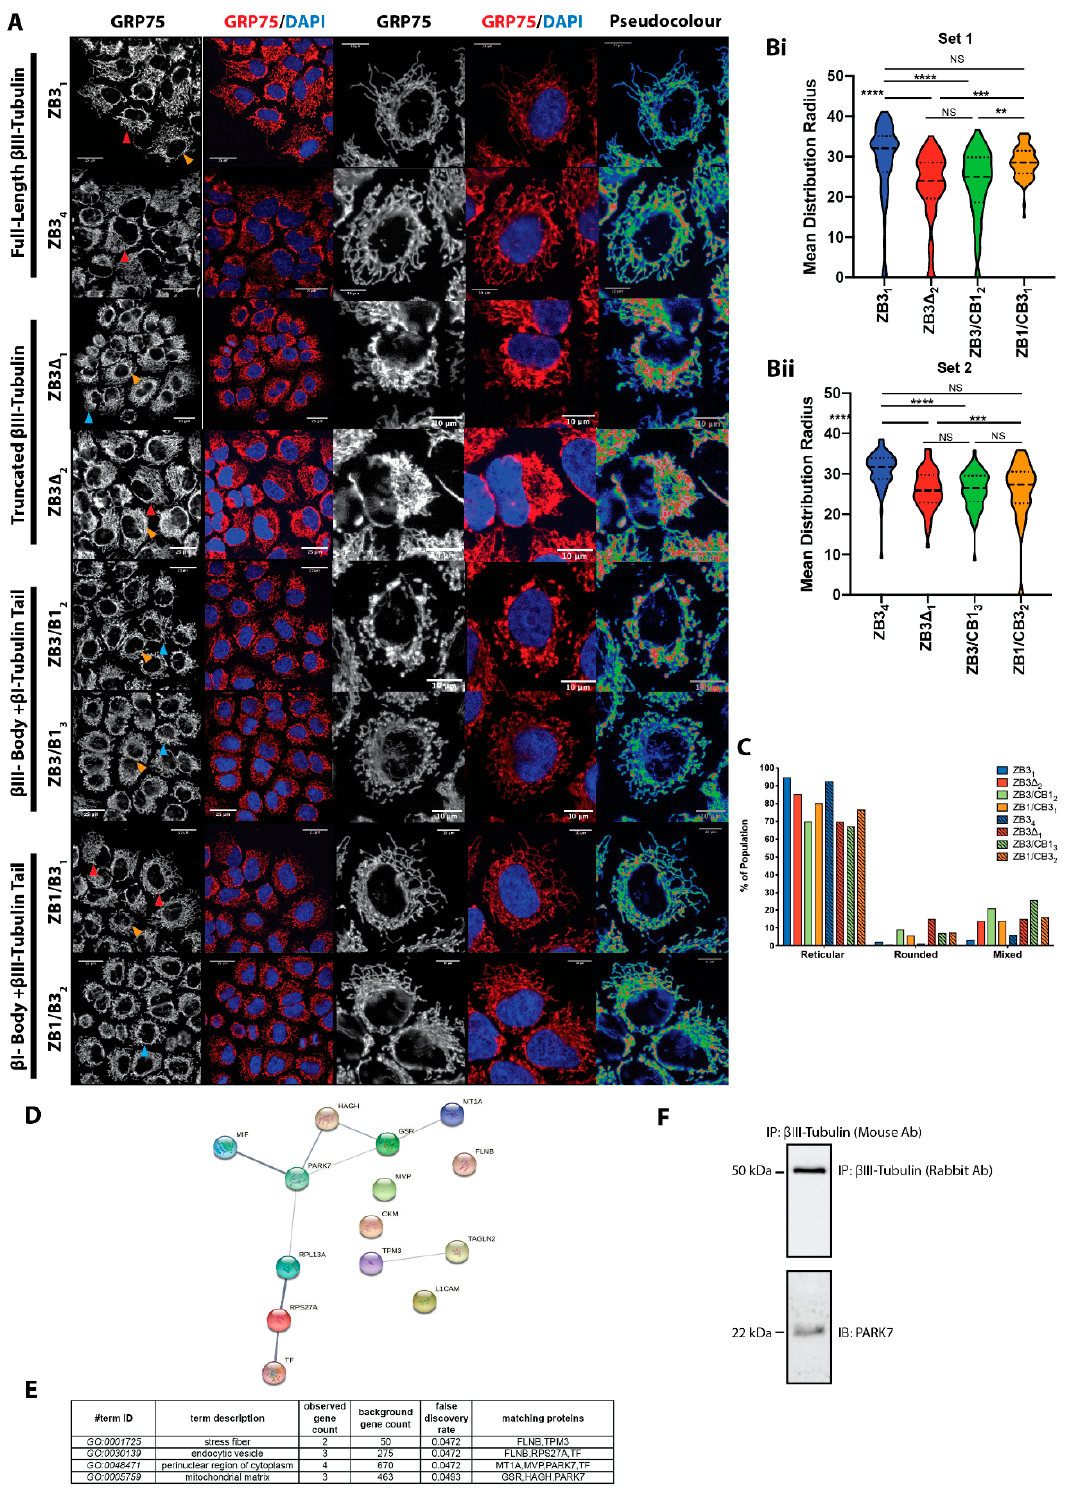
Figure 3. The β III-tubulin C-terminal tail regulates mitochondrial network structure and morphology. ( A ) Mitochondrial network distribution by GRP75 immunostaining (left panel: greyscale; right panel: GRP75 green, DAPI blue) in NCI-H460 expressing the full-length β III-tubulin protein (ZB3), truncated β III-tubulin (ZB3 Δ ), β III-tubulin with β I-tubulin C-terminal tail (ZB3/CB1), and β I-tubulin with β III-tubulin C-terminal tail (ZB1/CB3). Scale bars 25 mm for lower magnification and 10 mm for higher magnification. Red arrowhead: reticular mitochondrial morphology; blue arrow- head: rounded morphology; orange arrowhead: mixed morphology. Scale bars 25mm.